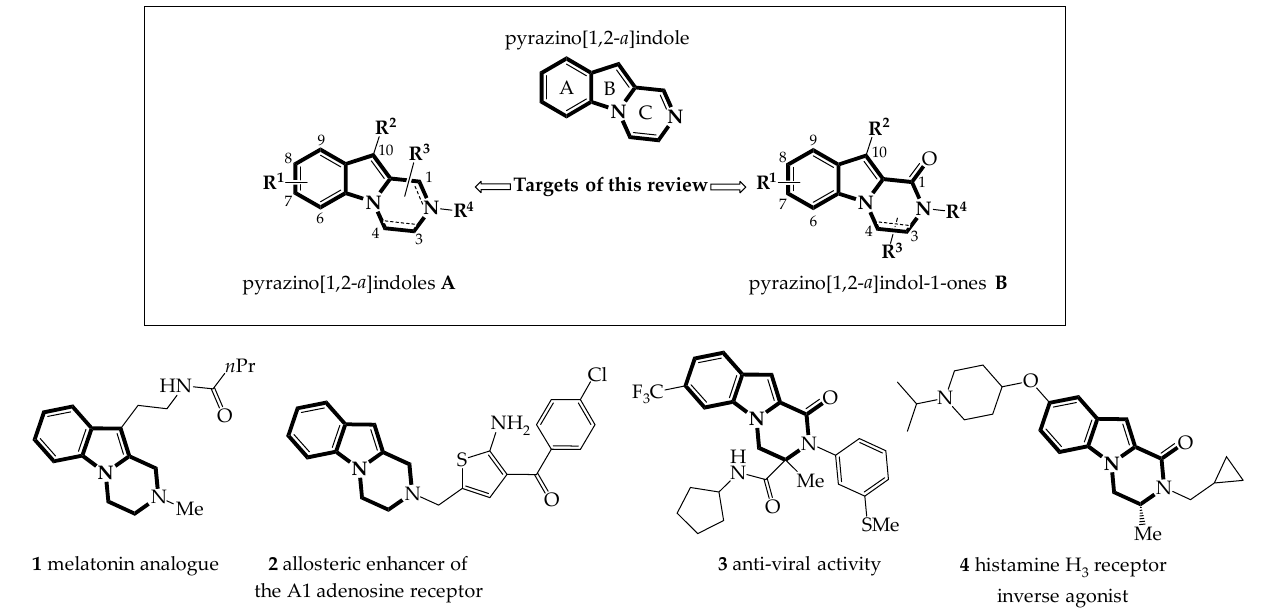
Figure 1. Targets of this review and selection of biologically active tetrahydro-pyrazino[1,2- a ]indoles 1a , 2a and dihydro-pyrazino[1,2- a ]indol-1-ones 3a , 4a .